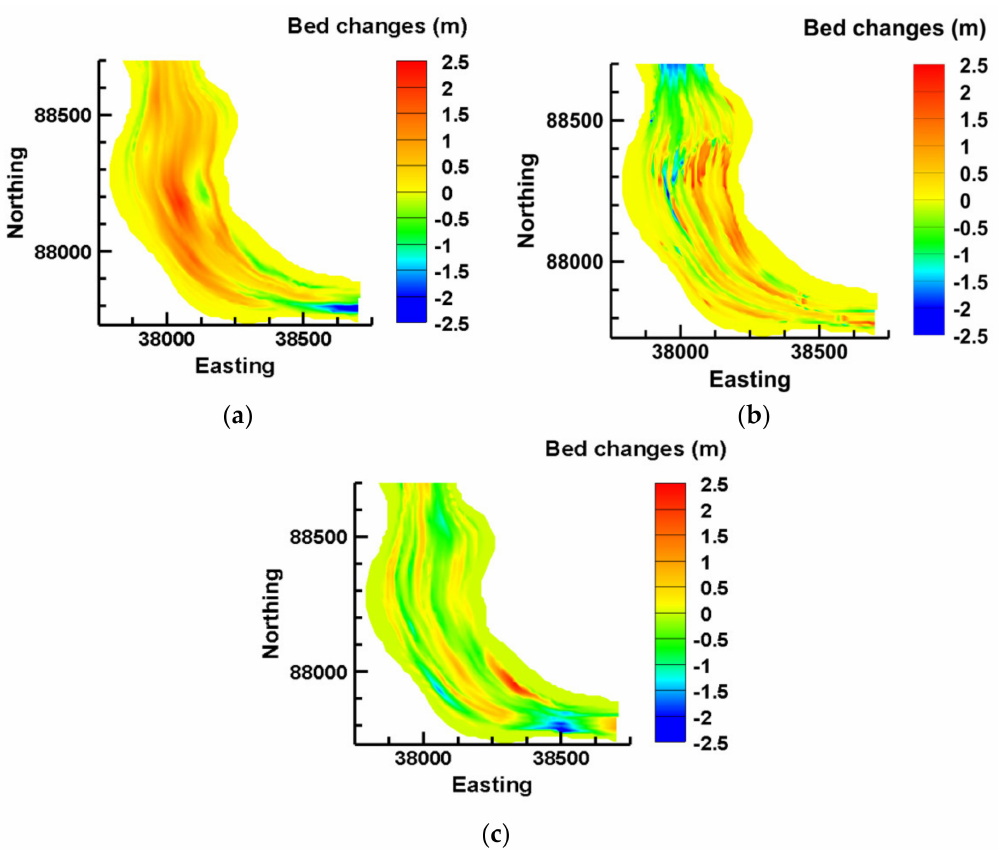
Figure 3. Plan view of the measured bed topographic changes in the study segment in the Unazuki Reservoir after flushing operation of year ( a ) 2010; ( b ) 2012; and ( c )